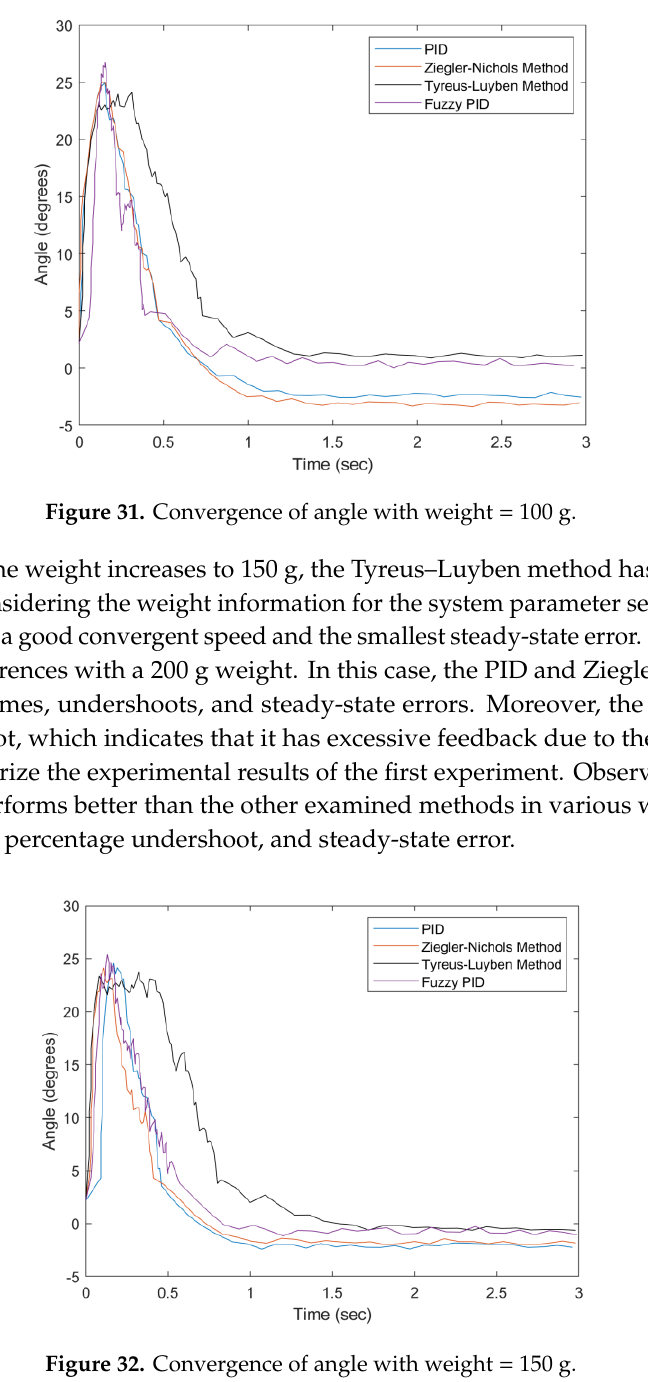
Figure 30. Convergence of angle with weight = 0 g.